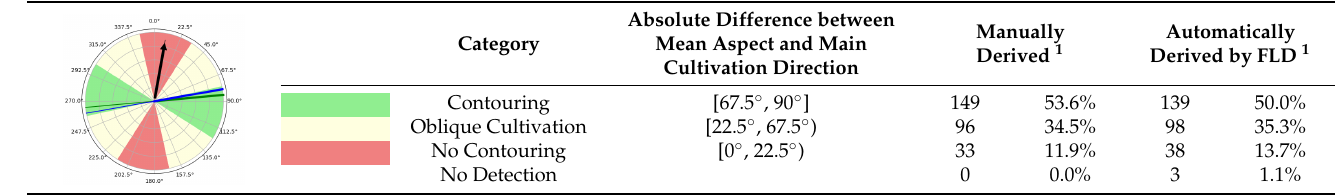
Figure 18. Results of FLD with parameters of ( a ) the shape area (different class widths) and ( b ) the compactness factor CIPQ; percentages describe the success rate of the FLD per interval. Finally, we present the results of the comparison of mean aspect and main cultivation direction in Table 8 for all 278 arable land parcels. From the smallest difference of these two directions, we categorized the support practice measure contouring into three cate- gories. Optimal contouring occurs when the two lines are orthogonal and the difference is in the interval [67.5°, 90°]. The category of no contouring exists for a cultivation along the direction of the aspect if the directions are almost parallel and the difference is in the interval of [0°, 22.5°). For values of the difference that lie in the interval [22.5°, 67.5°), we define an oblique cultivation. From this comparison, we deduced for the individual arable land parcels that the support practice measure contouring is used for 149 parcels (53.6%) within the Fischbach catchment. For 33 (11.9%) of the analyzed arable land parcels, the mean aspect corresponds to the main cultivation direction (no contouring). The conclu- sion for the FLD is comparable, only rather worse. At 50.0%, slightly fewer arable land parcels are categorized as having contouring, while 13.7% belong to the category no con- touring. The value for oblique cultivation is almost the same at 35.3%. The FLD was not able to determine a cultivation direction at all for three images. Table 8. Final results for the application of the support practice measure contouring comparing the mean aspect vs. the main cultivation direction. Example illustration on the left: Representation of the classification for contouring with mean aspect (black arrow) and cultivation direction manually derived (blue) and automatically derived (green).